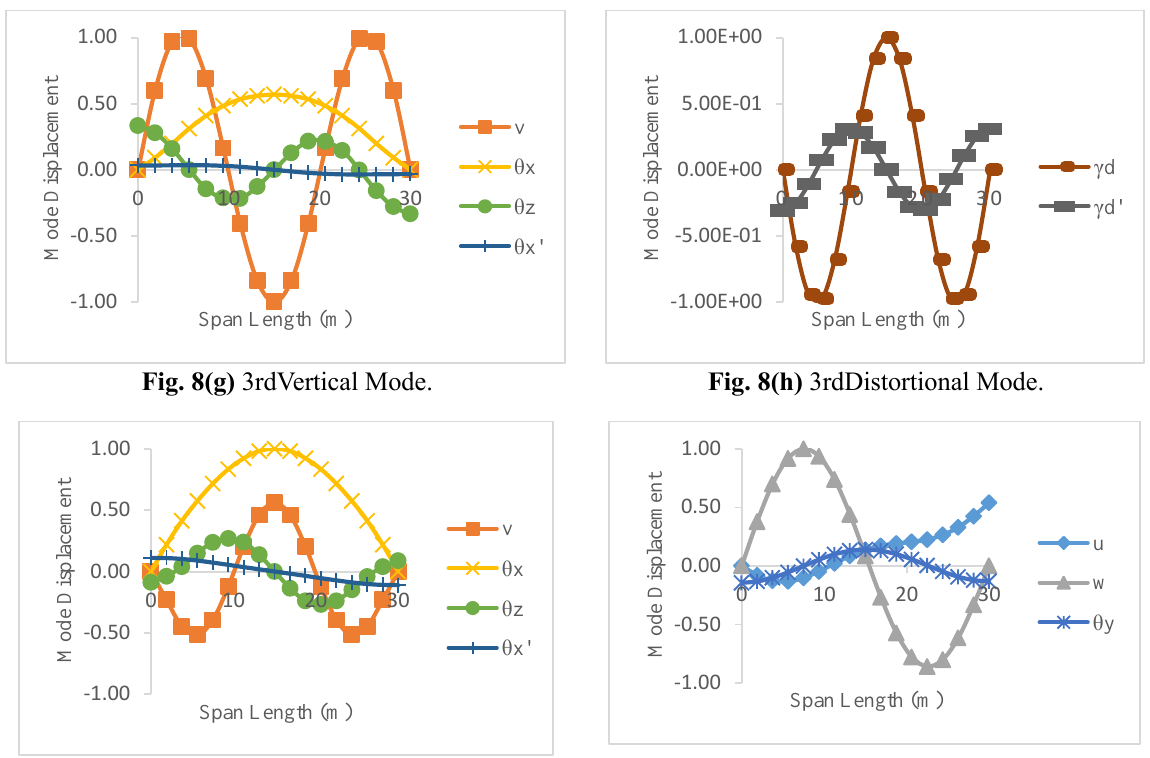
Fig. 8(g) 3rdVertical Mode. Fig. 8(h) 3rdDistortional Mode.